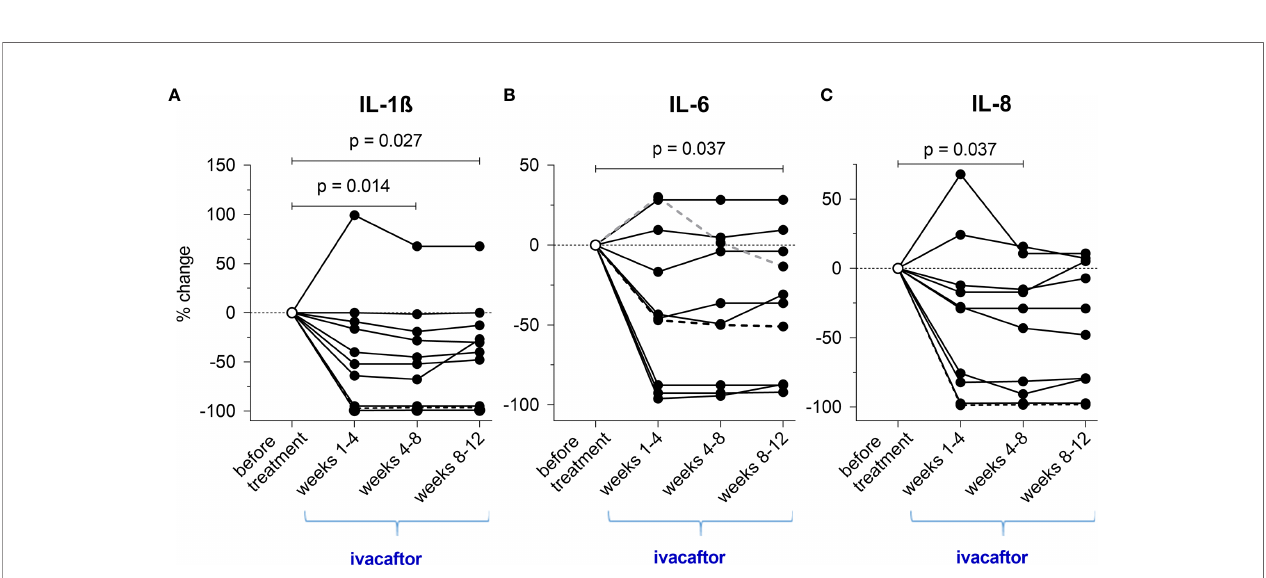
FIGURE 4 | (A – C) Cumulative changes of in fl ammatory cytokines during the novel ivacaftor-therapy (regarding each periods of 4 weeks during